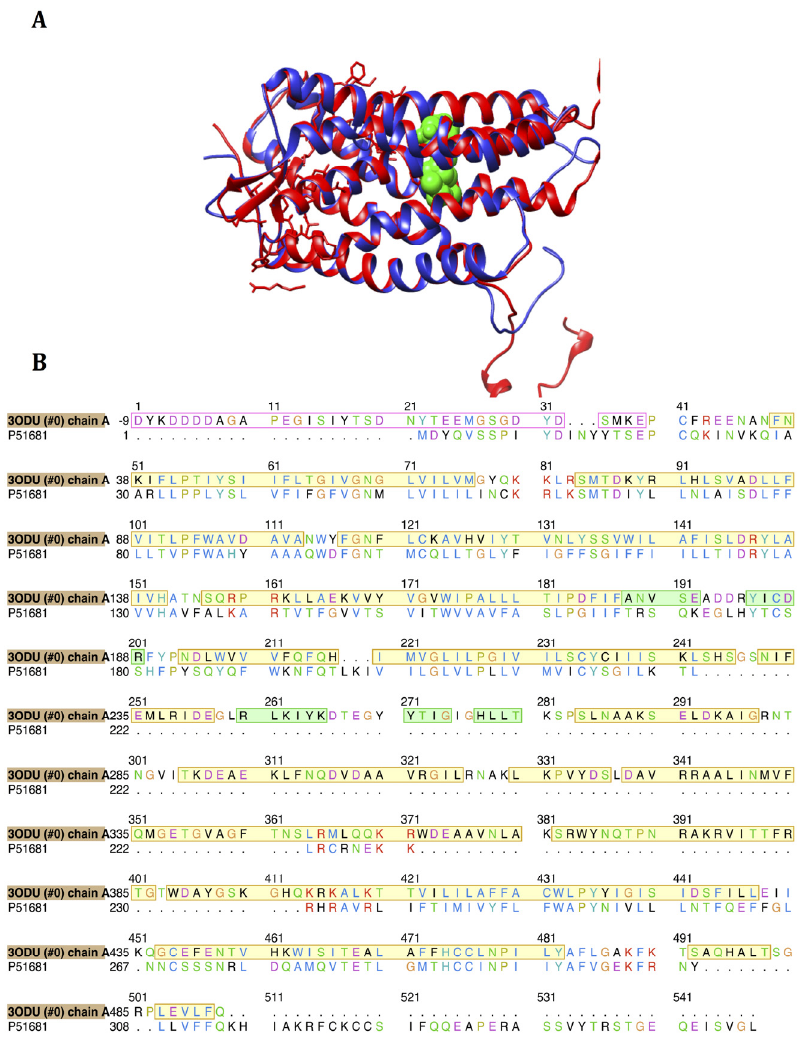
Figure 5. ( A ) Superimposed structures of 3ODU [16] and modeled CCR5 enzyme (blue) with CCR5 antagonist, maraviroc [24]; ( B ) The 2D sequence alignment of 3ODU and the homology model generated for our study. Yellow highlighting represents α -helices and green highlighting represents β -sheets. Sequences outlined in red lack 3D crystal